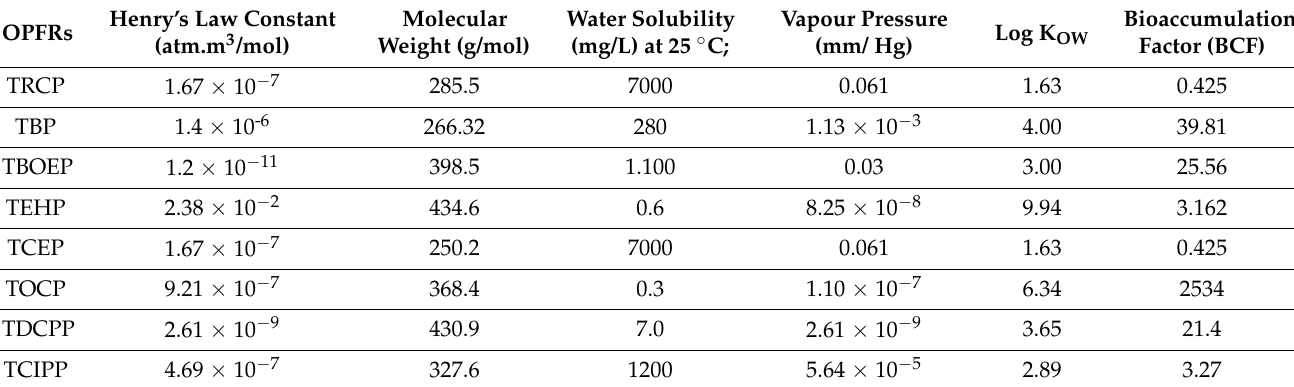
Table 2. Table showing the list of some major OPFRs with their water solubility, adsorption to